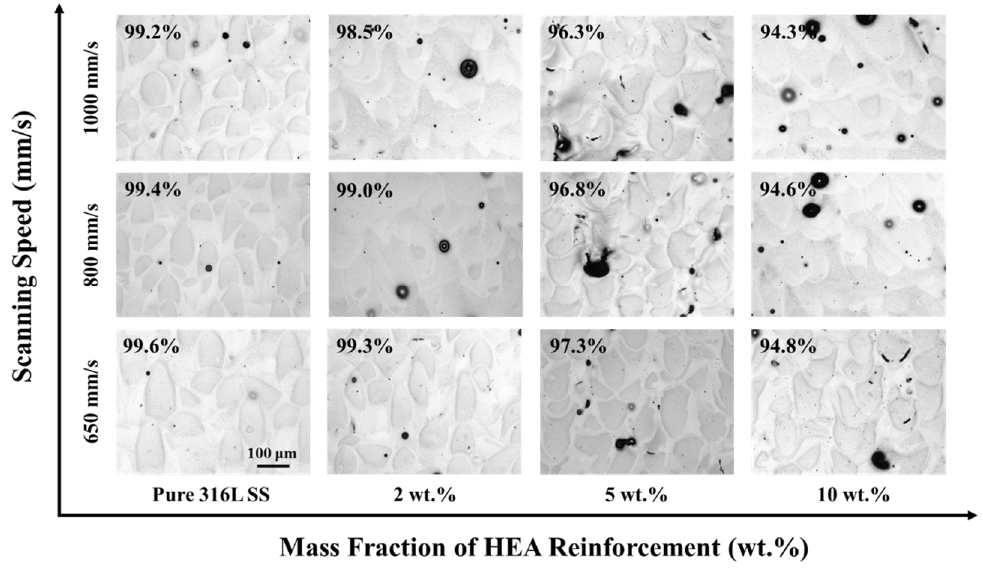
Figure 3. The distribution of the porosity with different reinforcement ratio and scanning speed.